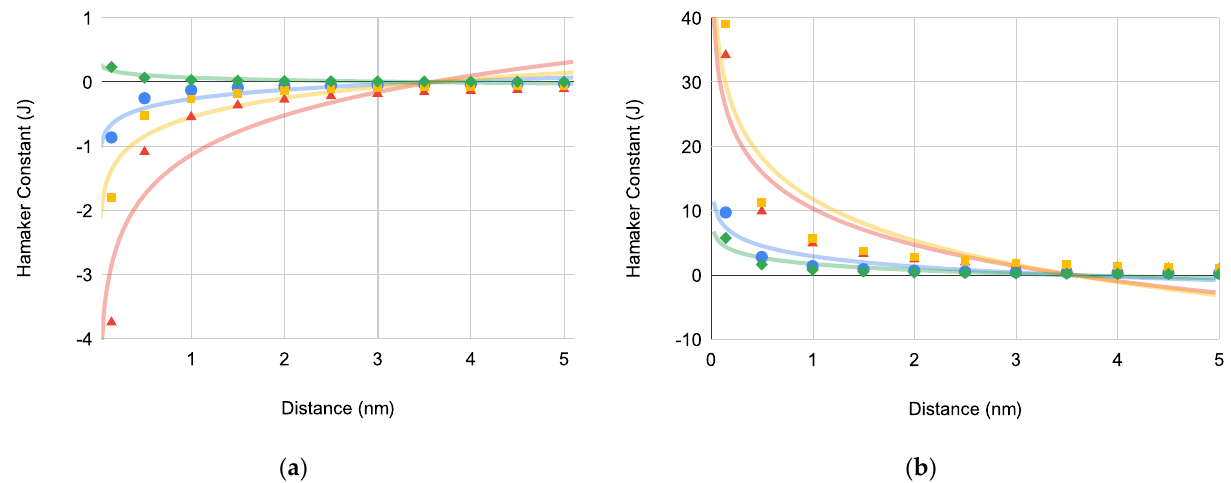
Figure 2. Hamaker constants ( × 10 11 ) versus distance to determine equilibrium distances accounting for bacteria-substrate interaction geometries and bacterial surface area for PA (blue circles), EC (green diamonds), SA (red triangles), and SE (orange squares) with: ( a ) superhydrophobic substrates where 𝑑 𝑒𝑞 is 3.58 ± 0.00479 nm ( N = 4) and ( b ) superhydrophilic substrates where 𝑑 𝑒𝑞 is 3.58 ± 0.00250 nm ( N = 4).